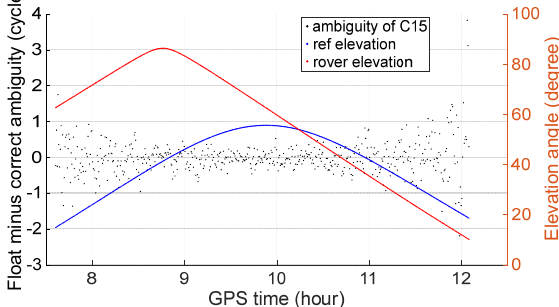
Figure 5. Ambiguity resolution of wide lane C15.